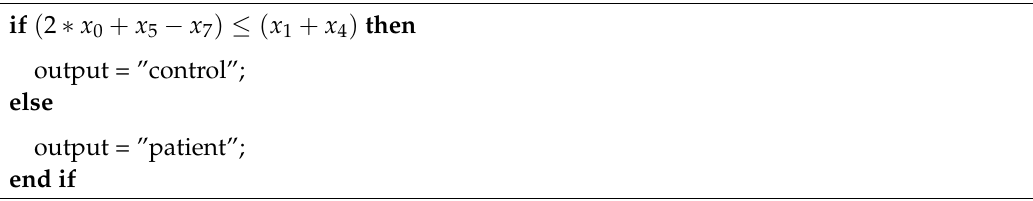
Algorithm 3 The simplest model evolved by CGP among all the 20